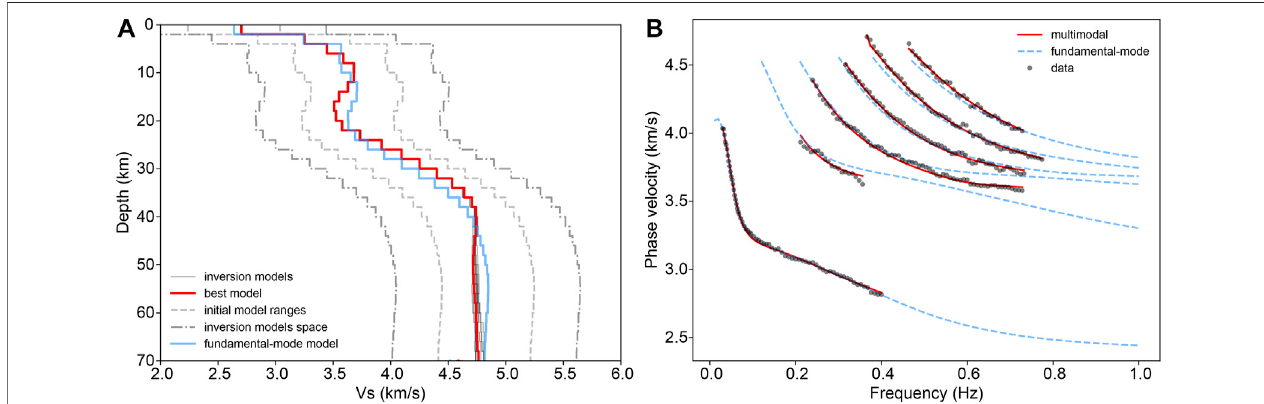
FIGURE4| Inversionand fi ttingresultsofthemultimodaldispersioncurvesofarray “ TH ” . (A) Thebluelineisthefundamental-modevelocitymodel,andtheredand blacklinesarethe fi rsttenwell- fi ttingmodelsobtainedfromtheinversionofmultimodaldispersioncurves,wheretheredlinedenotesthebest- fi ttinginversionmodelwith the smallest objective function value, namely, the fi nal model of the multimodal dispersion curve inversion. (B) The black points are the picked multimodal dispersion points, the red lines denote the theoretical multimodal dispersion curves of the fi nal model of the multimodal dispersion curve inversion, and the blue dashed lines are the theoretical multimodal dispersion curves of the fundamental-mode velocity model.